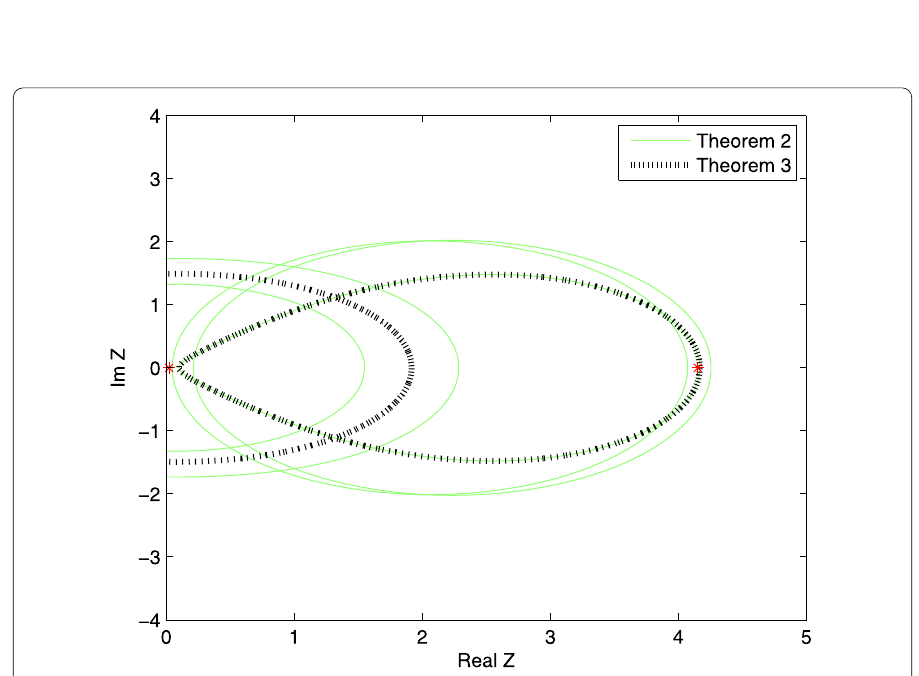
Figure 1 Comparisons of Theorem 1(i), Theorem 1(ii) and Theorem 2 for Example 1.